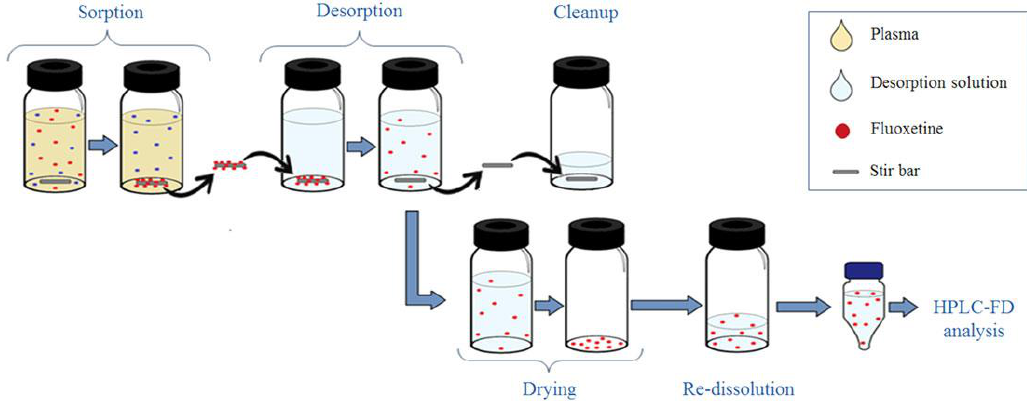
Figure 10. Extraction procedure of fluoxetine by stir bar sorptive extraction (SBSE) in plasma [115].